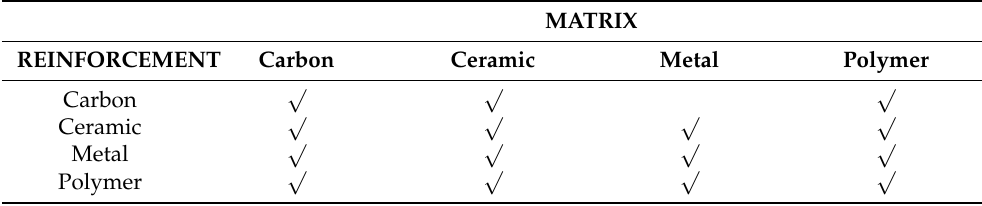
Table 5. Varieties of